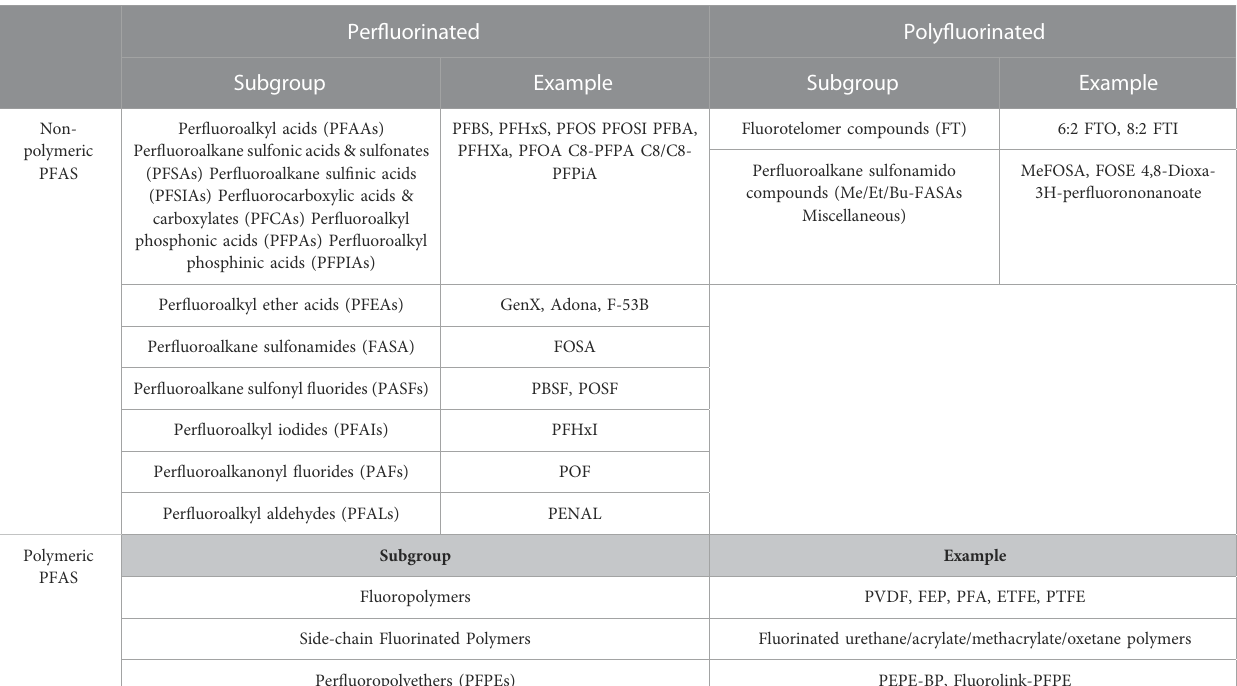
TABLE 1 List of the PFAS according to their categories and subgroups [adapted from (Panieri et al.,